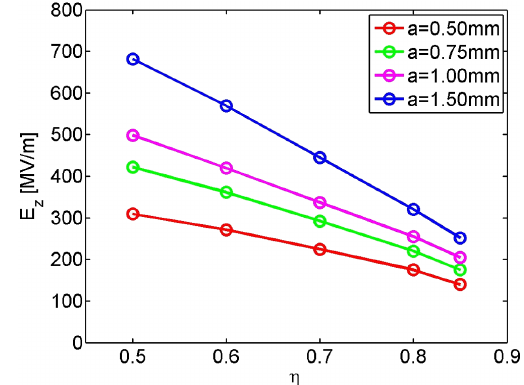
8. Maximum acceleration gradient as a function of efficiency η . Higher gradient limits can be achieved by sacrificing the